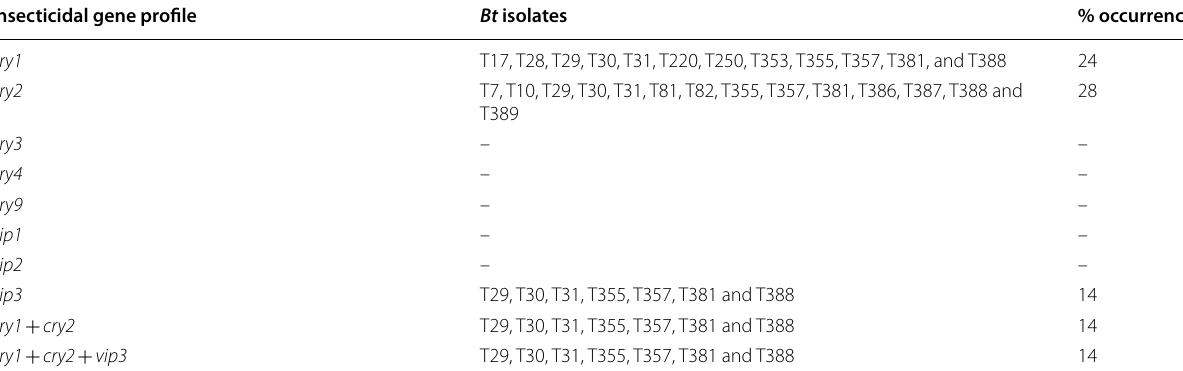
Table 4 Insecticidal gene profile of indigenous Bt isolates from PCR screening Insecticidal gene profile Bt